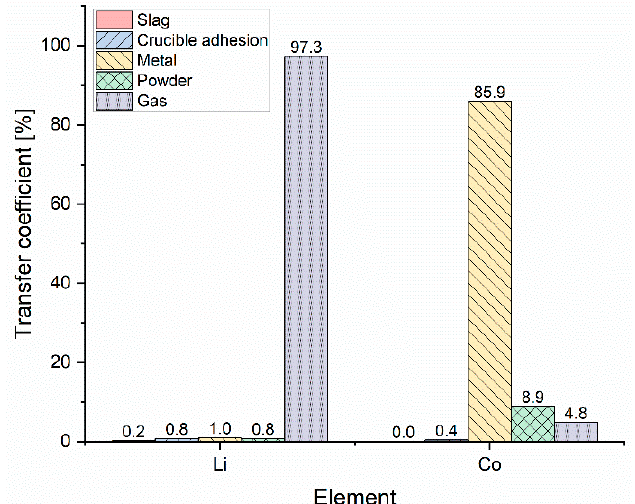
Figure 13. Transfer coefficients of the elements into the individual fractions in % of the experiment in Design 2.